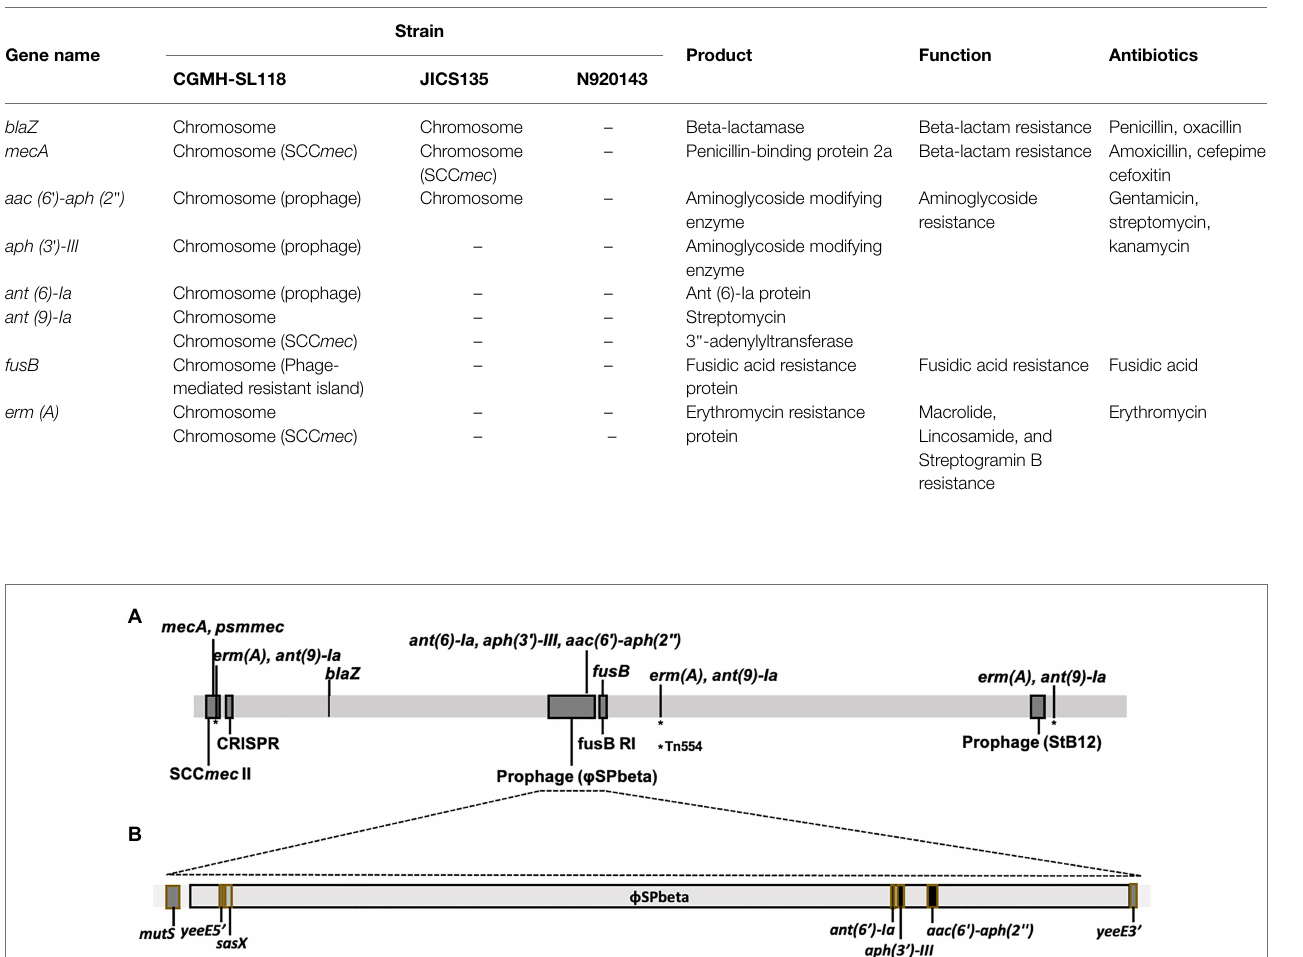
TABLE 3 | Comparison of antibiotic-resistant gene distribution between CGMH-SL118 and other reference strains.